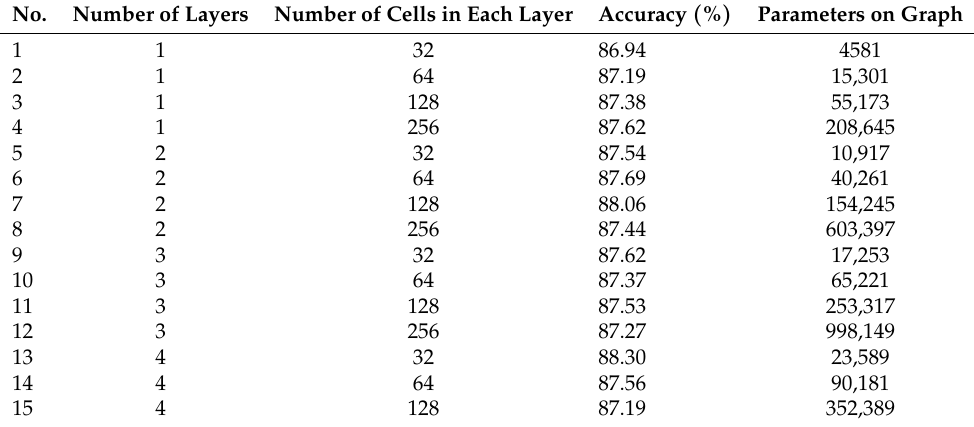
Table 1. Network configurations, accuracies (validation set), and the number of parameters on the